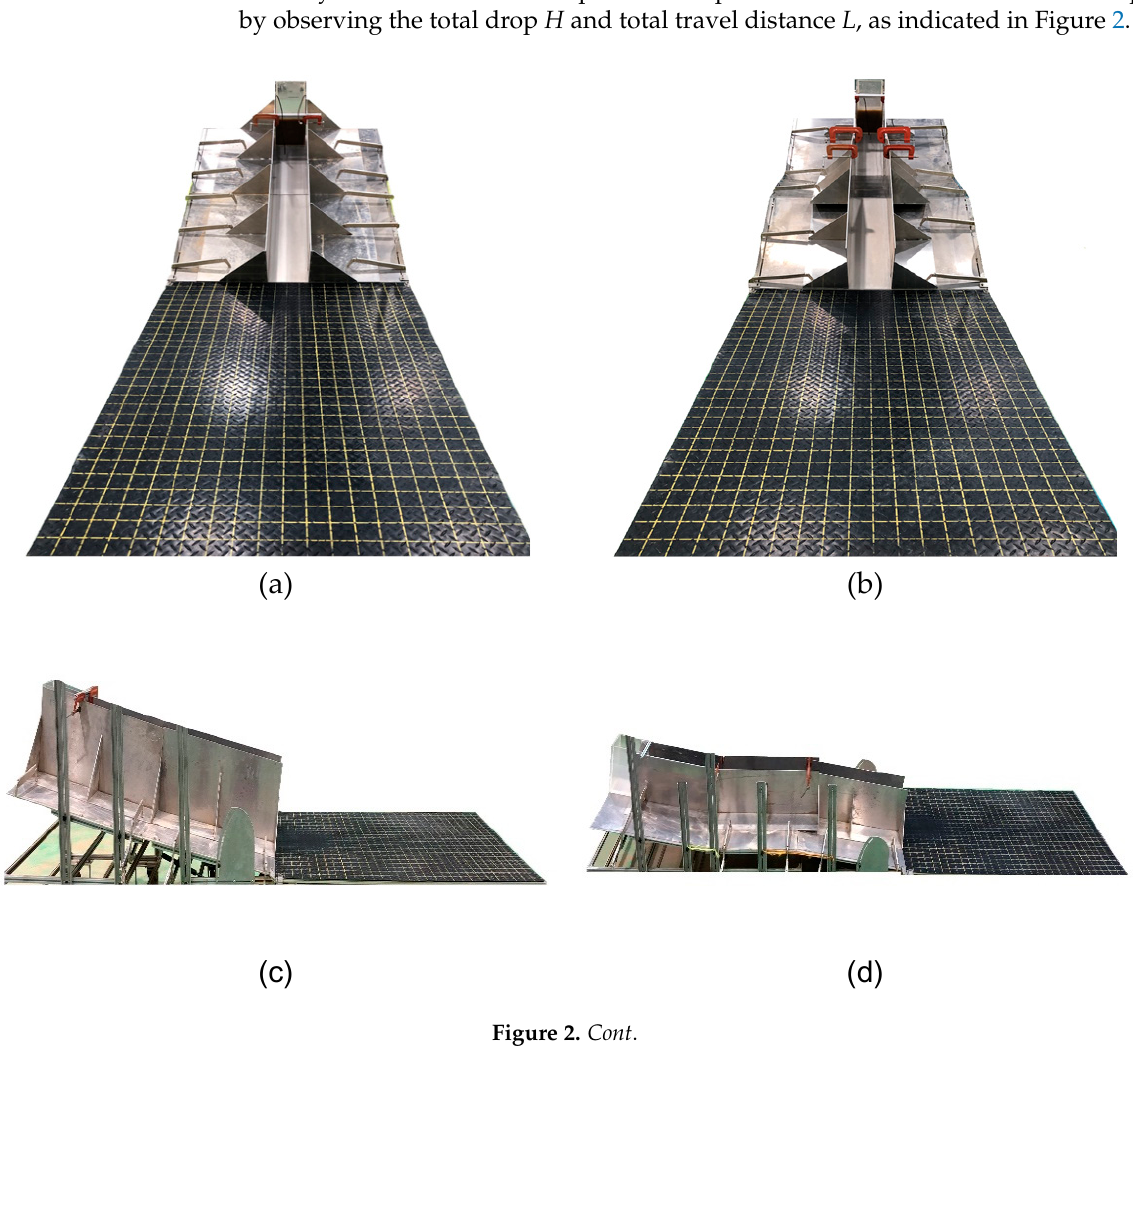
Table 2. Dimensions of the channels for each test